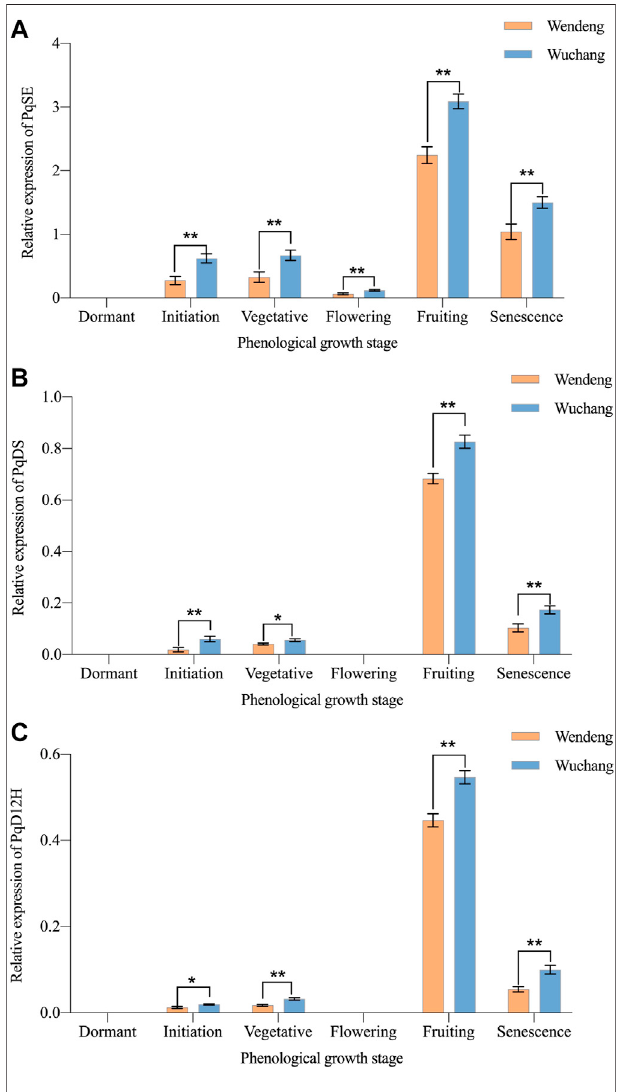
FIGURE 7 | Genes expression dynamics of ginsenoside biosynthesis at different phenological stages of American ginseng harvested from Wendeng and Wuchang. Note: PqSE, the gene of squalene epoxidase in P. quinquefolium (A) ; PqDS, the gene of dammarenediol synthase in P. quinquefolium (B) ; PqD12H, the gene of protopanaxadiol synthase in P. quinquefolium (C) . The results are expressed as mean value ±SD (n = 3) (* p < 0.05, ** p <